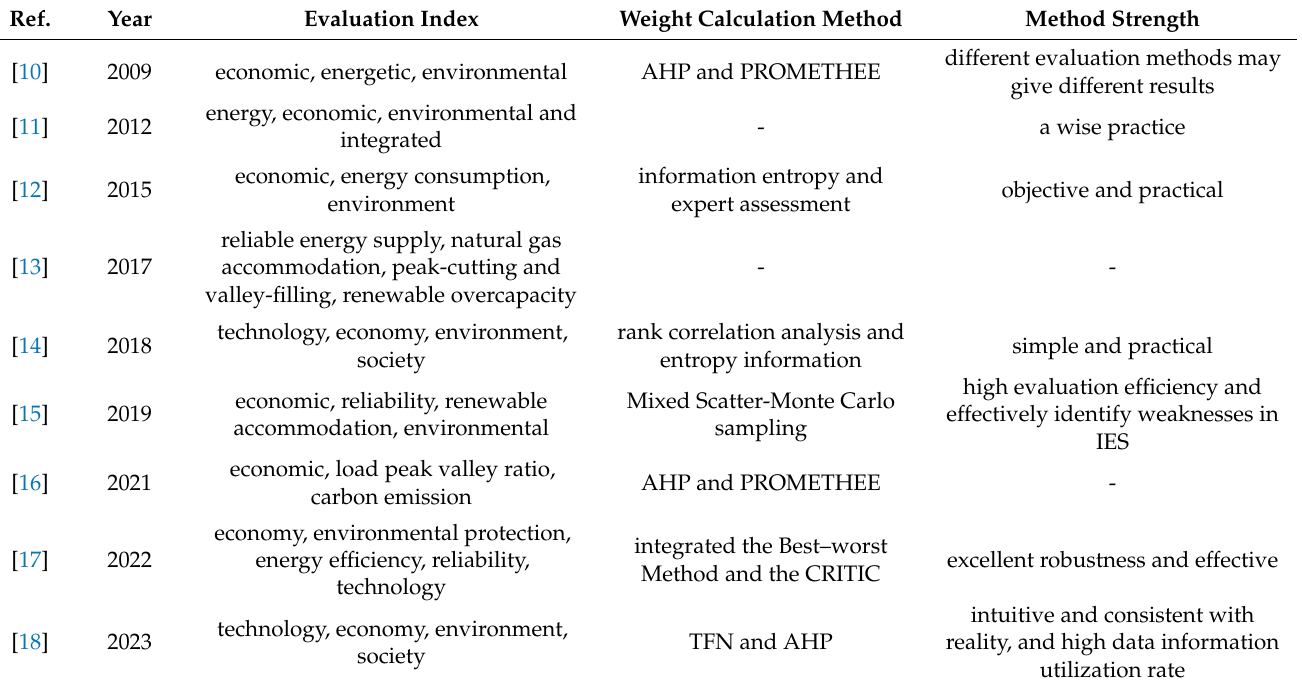
Table 1. The development of research in the evaluation index for IESs.